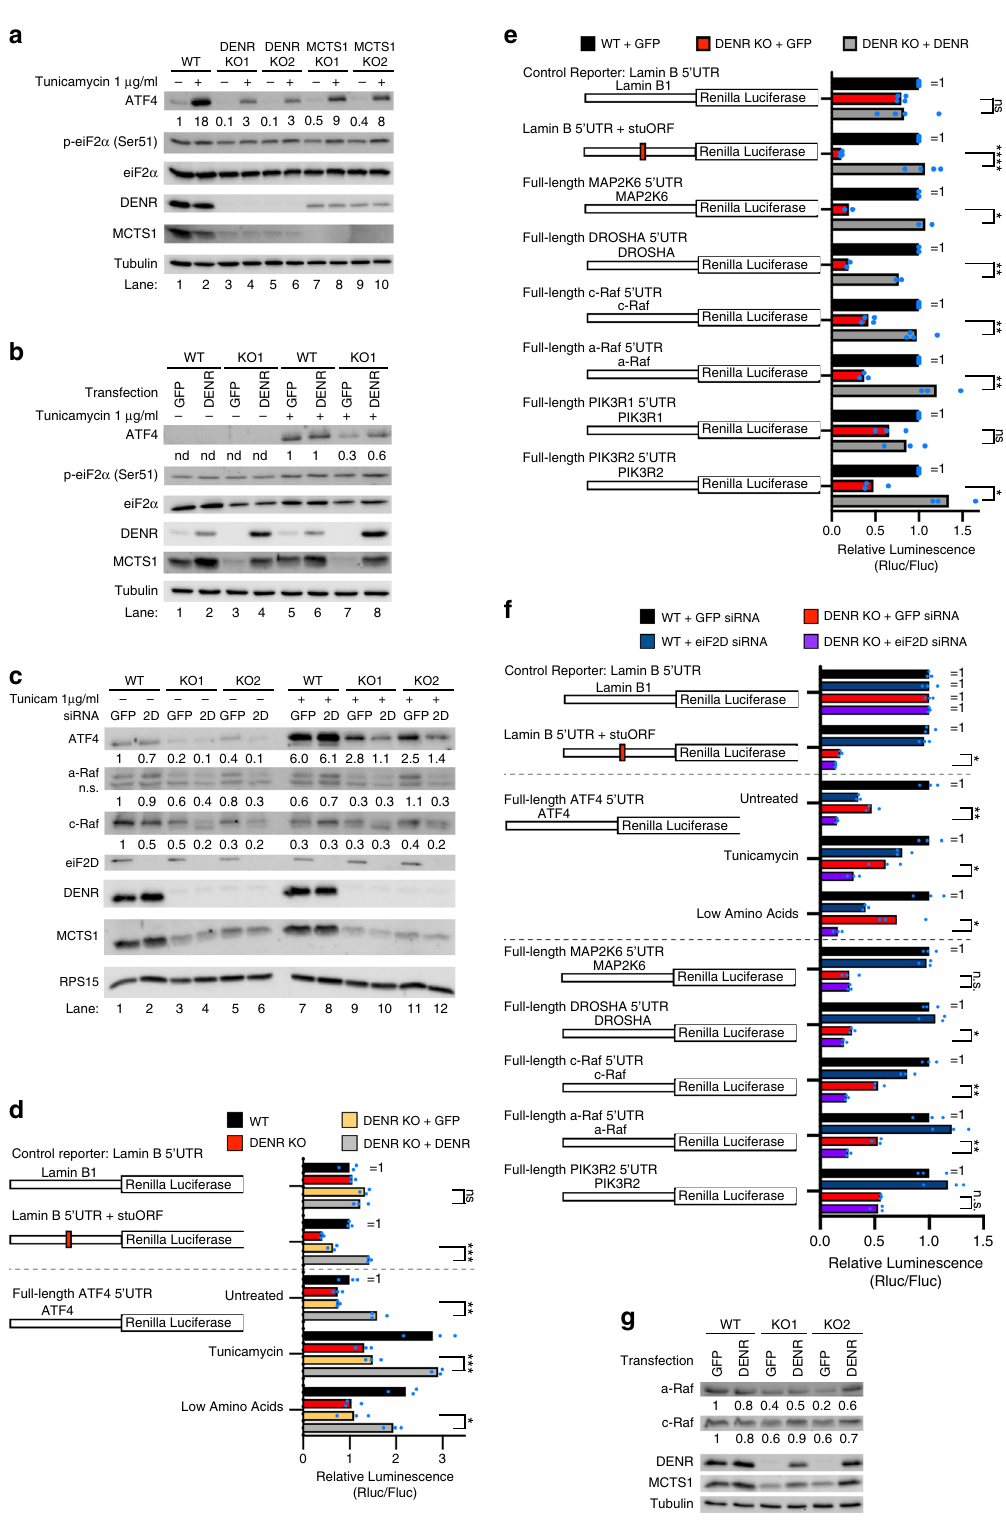
of the reporter to become DENR independent (Supplementary Fig. 5a). Interestingly, the penultimate (second to last) codon of a-Raf uORF1 and the third-to-last codon of ATF4 uORF2 are both GCG Ala , suggesting codon identity might be important. Therefore, we generated synthetic reporters containing 2-aa uORFs where the fi rst codon is ATG and the second codon was varied. This con fi rmed that a GCG Ala penultimate codon renders